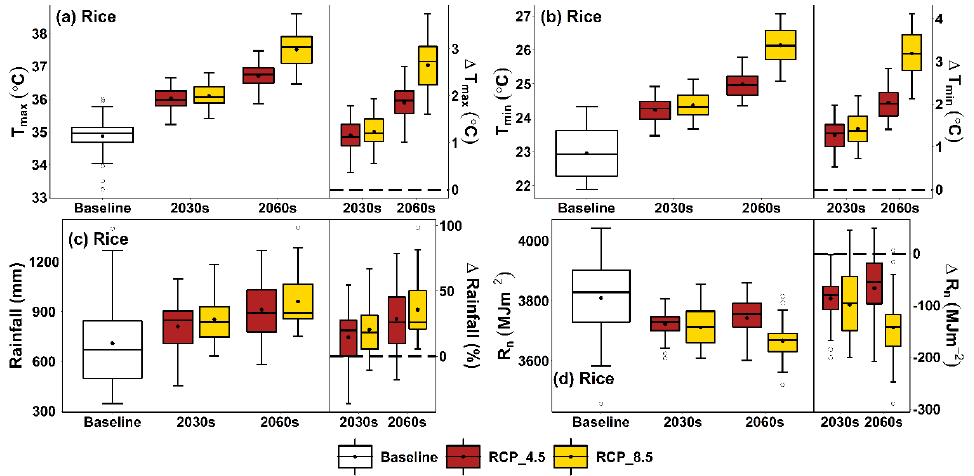
Figure 3. Rice seasonal (May–October) average ( a ) maximum temperature (T max ), ( b ) minimum temperature (T min ), and ( c ) seasonal cumulative rainfall (P), as well as the ( d ) solar radiation (R n ) during the baseline (1980–2010), 2030s (2021–2050), and 2060s (2051–2080). Figure 4 and Table 1 show the MK test Z-scores and Sen’s slope for interseasonal trends of the T max , T min , R n , and P during the baseline and future time slices. Except for an unchanged T max trend during the baseline rice season, the T max and T min trends significantly ( α = 1%) increased regardless of the time slice, RCP, or cropping season. Sen’s slopes of the wheat and rice season T max and T min trends were almost similar for a certain time slice or RCP, with an overall change range of 0.02–0.06 ◦ C/year (Table 1). The future P trends for both crops were mainly non-significant, regardless of their direction. The wheat season P trends were downward throughout the baseline and future time slices, and these were significant only during the baseline ( α = 5%) and 2030s under RCP 4.5 ( α = 10%). Conversely, the rice season P trends were upward across the baseline and future time slices and only significant during the 2030s under RCP 8.5 ( α = 1%). The wheat season R n trends were highly significant ( α = 1%) during the baseline, 2030s (RCP 8.5), and 2060s (RCP 4.5), but the rice seasonal R n trends did not follow a particular pattern across the time slices of the RCPs. During the 2030s and 2060s, the rice seasonal R n trends were significant ( α = 1%) only under RCPs 8.5 and 4.5, respectively (Figure 4 and Table